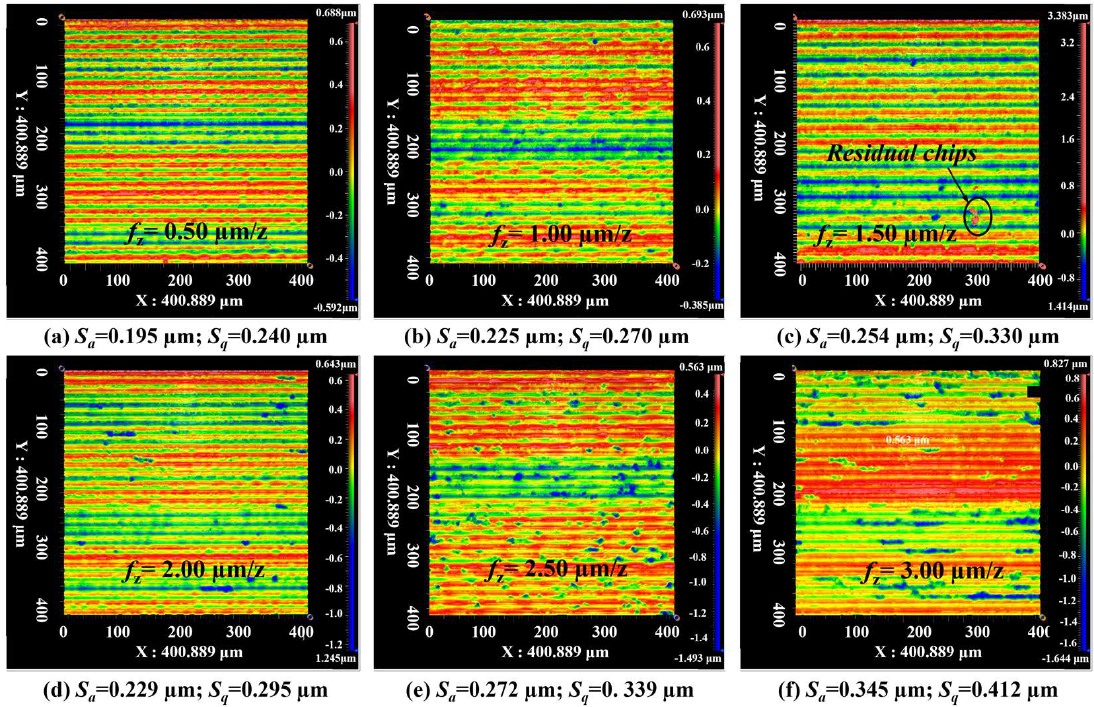
Figure 5. 3D morphologies of micro-milled KDP surfaces at various feed rates per tooth.